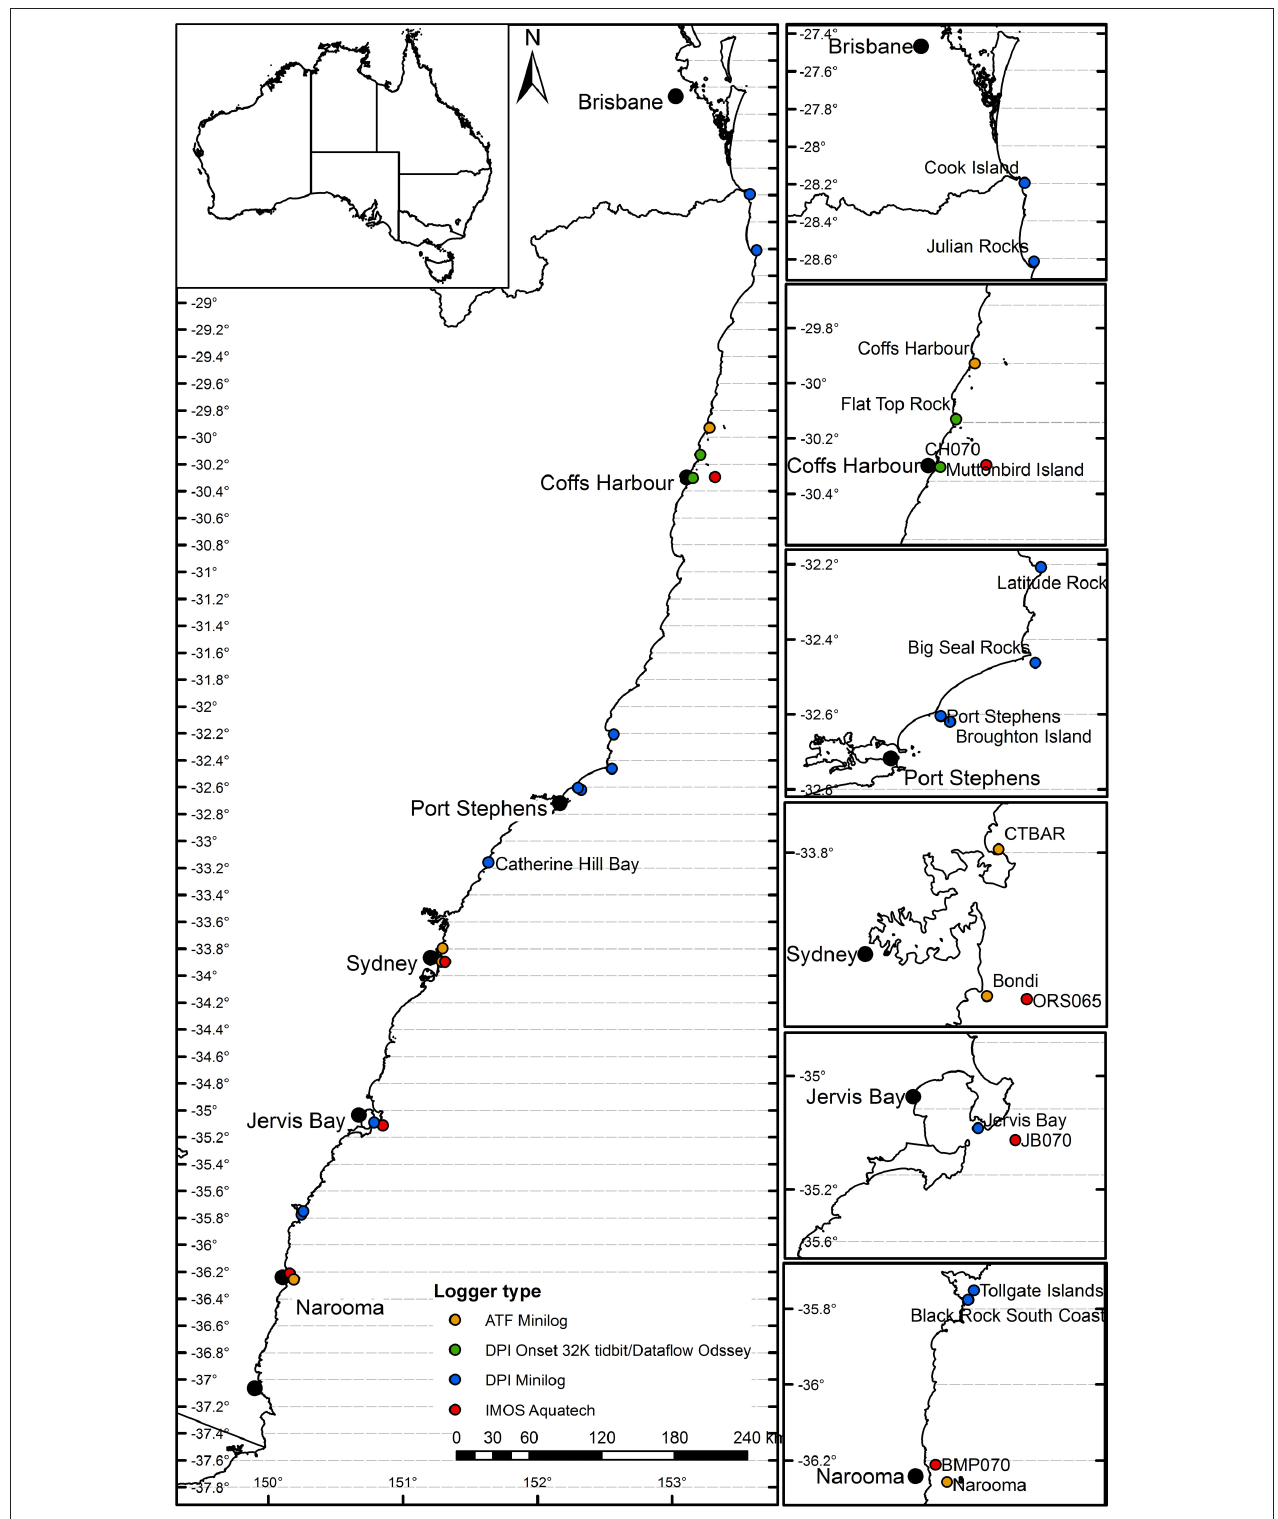
FIGURE 1 | Study site map showing the location of each in situ mooring and logger. Horizontal lines indicate the 0.20 ◦ of latitude that is used to average the data in the remaining figures.